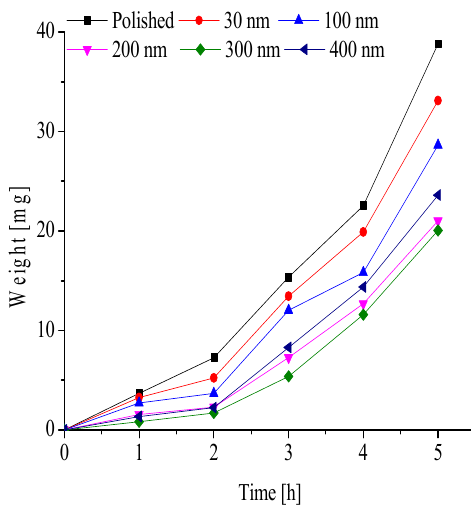
Figure 11. Variations of frost weight with different nanoporous diameters at T = − 10 °C, φ = 60%.